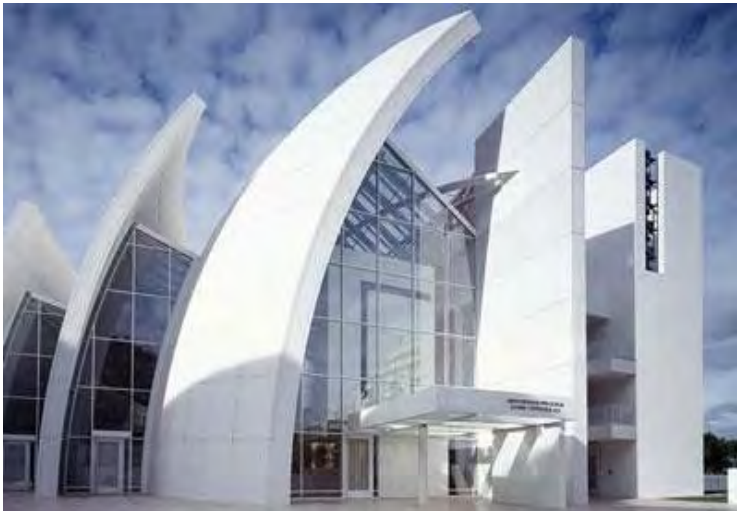
Figure 9. TheJubilee Church built with photo-catalytically active, “self-cleaning”